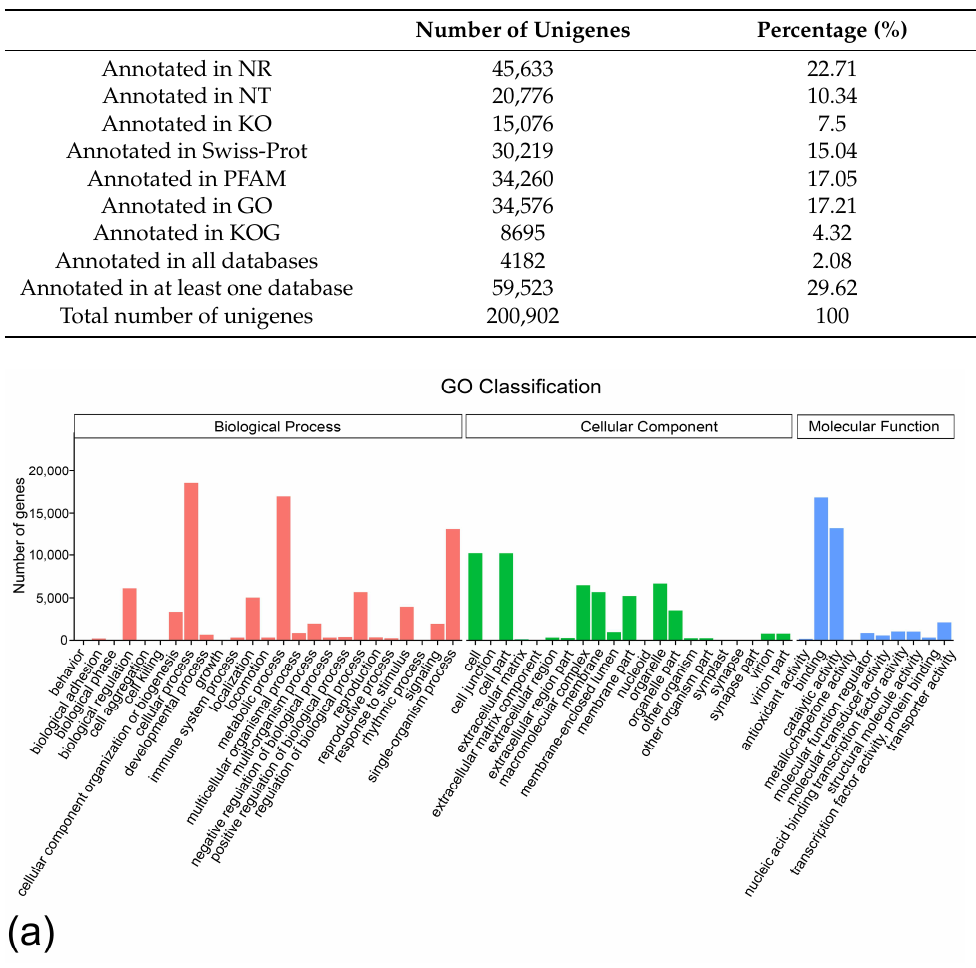
Table 2. The statistics of unigene annotation.